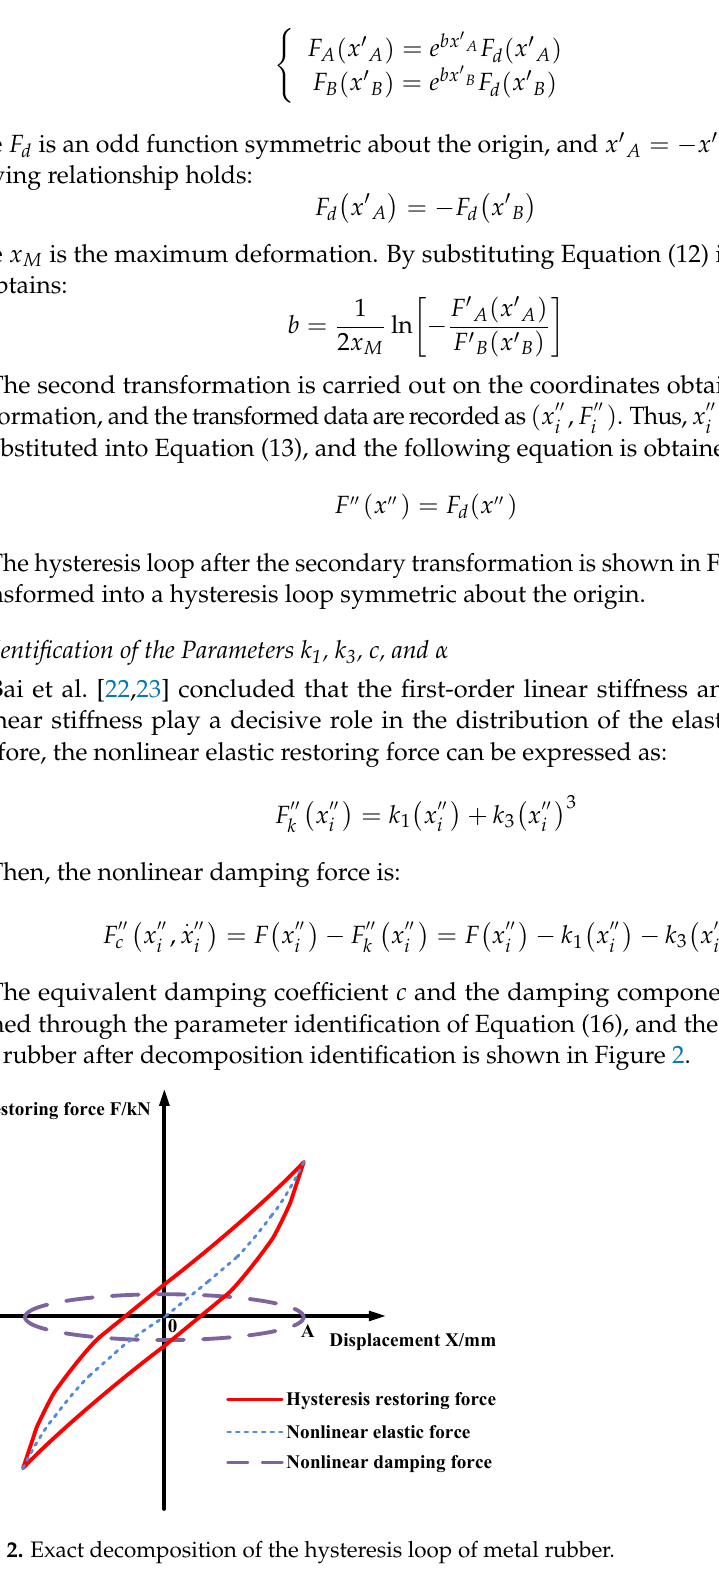
Bal. Figure 3. ( a ) The fabricated pot-shaped metal rubber, and ( b ) the dimensions of metal rubber. Polynomial fitting is selected for the parameter identification due to its simple struc- ture and good fitting accuracy [24]. According to the curves of the parameters h and b as